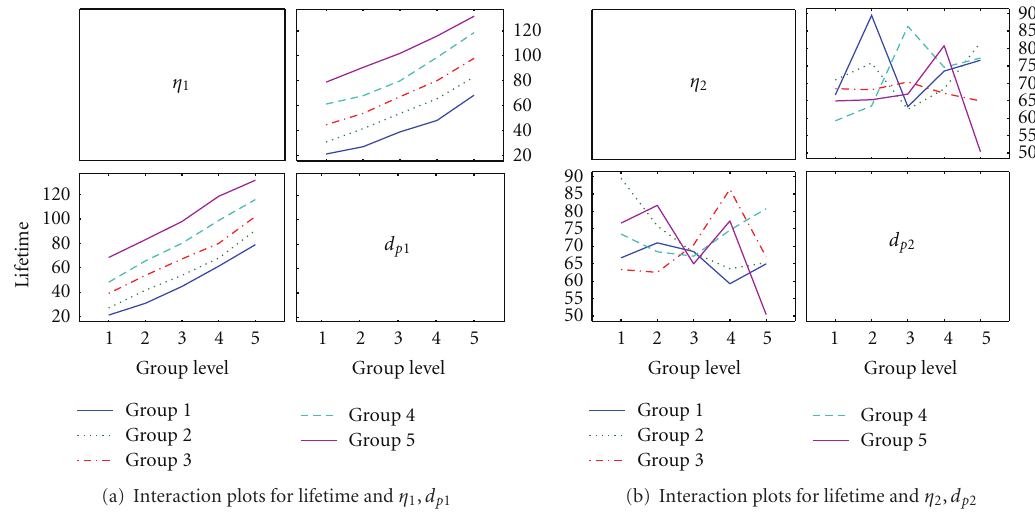
Figure 8: Interaction plots for filter lifetime for parameters in layers 1 and 2. The legends are the same for both plots.